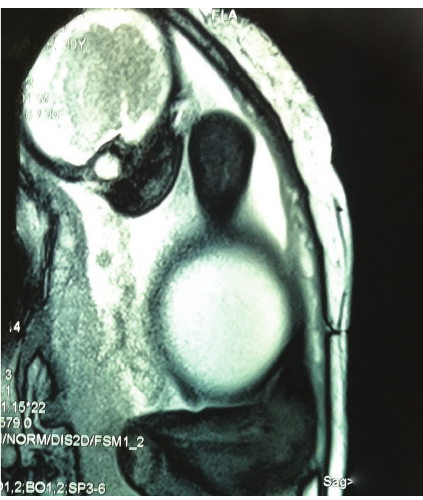
Figure 1: Magnetic resonance urography was done in 34th week of gestational age which shows a large cystic mass measuring 8 ∗ 9 cm in the right abdominal part above the right kidney.